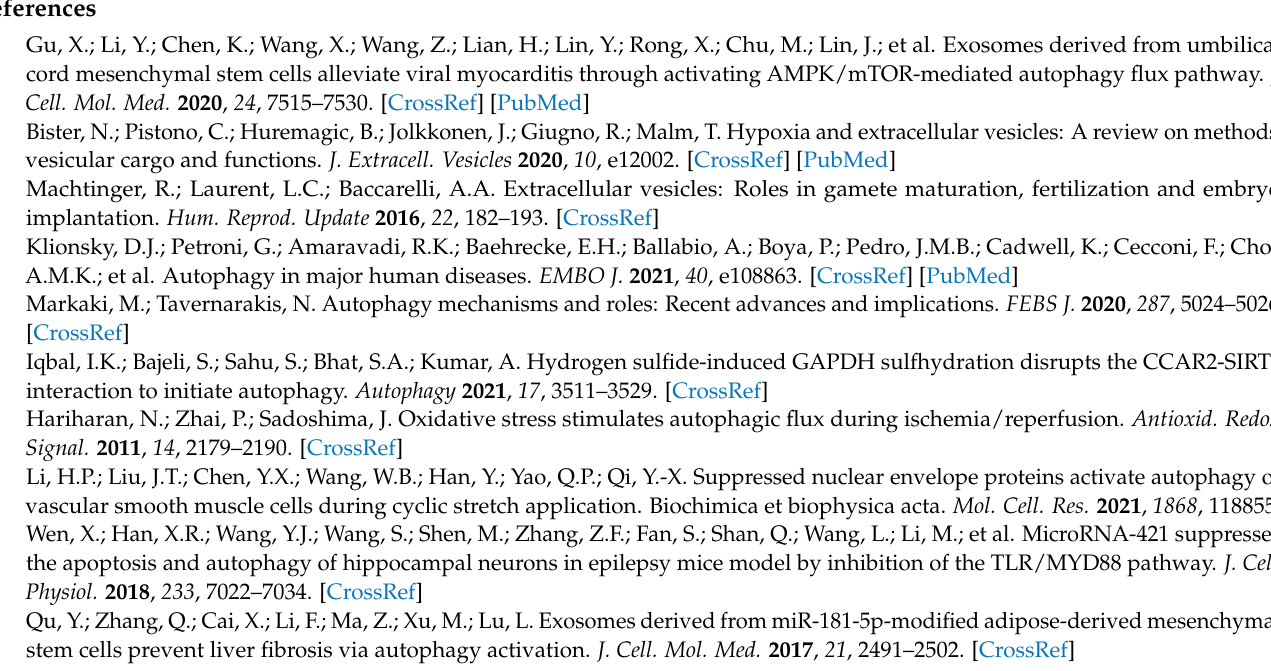
exosomes.; Figure S2: Yak follicular fluid can activate autophagy in YCCs. Figure S3: 3-MA inhibits autophagy and reduces 2-OHE2 secretion in YCCs. Figure S4: RAPA increases 2-OHE 2 secretion by upregulating autophagy in